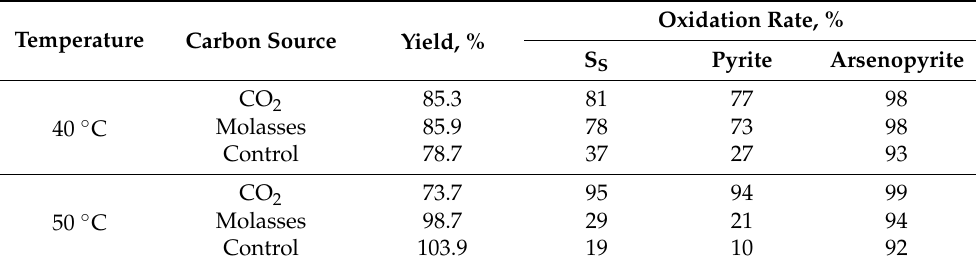
It should be noted that the mass yield of the solid residue of the concentrate bio- oxidation in reactors 1 and 2 was higher than in reactor 3, despite the more intense bio-